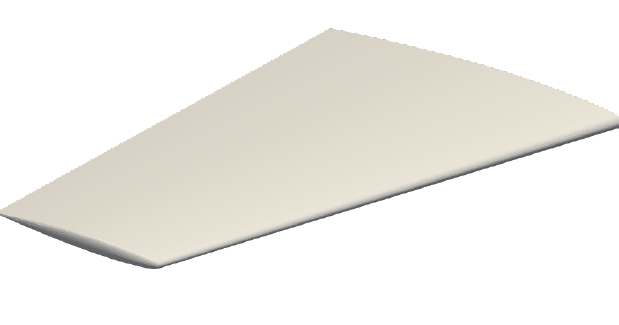
Figure 1. Onera M6 wing model. Table 2. Geometrical properties of the Onera M6